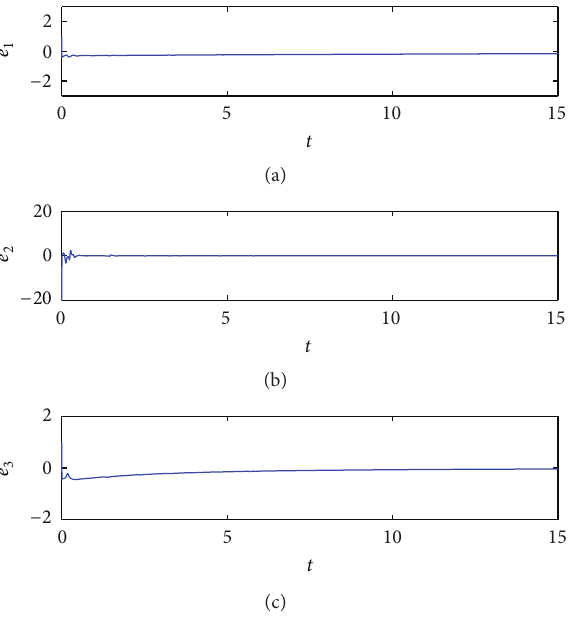
Figure 11: The trajectories of the adaptive laws 𝑘 31 , 𝑘 32 , and 𝑘 33 in Example 1.